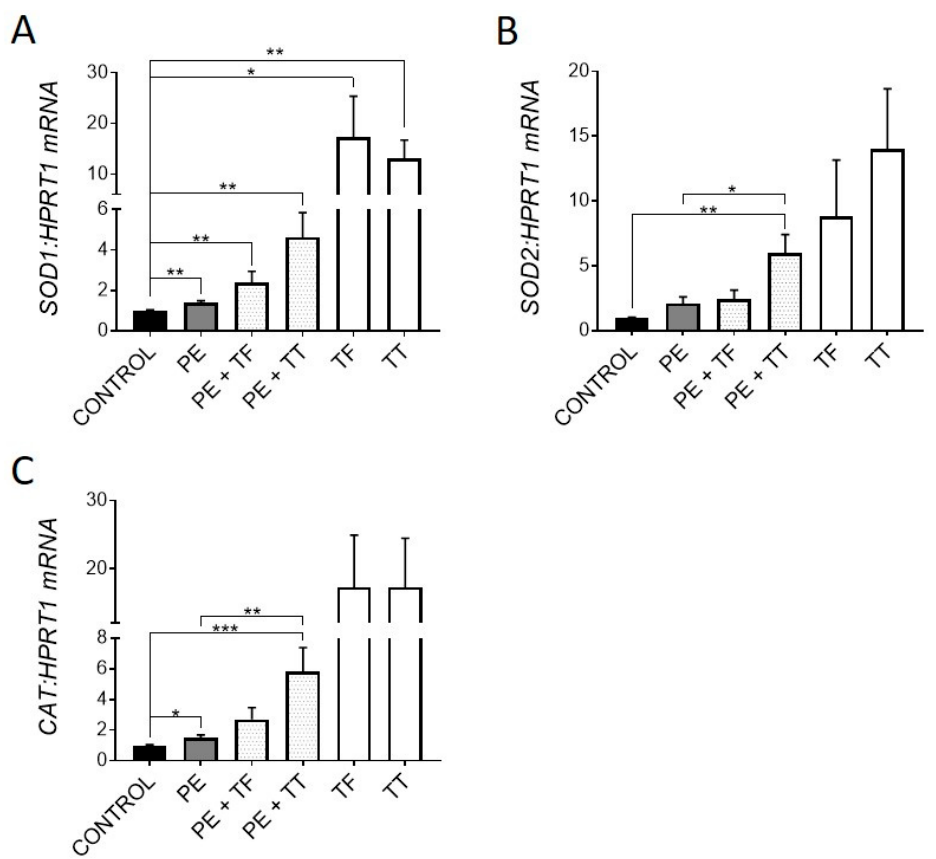
Figure 1. Effect of vitamin E and UHMWPE particles on antioxidant gene expression. Human osteocyte-like cultures were overlaid with collagen gel containing UHMWPE particles (PE) and either α -Tocopherol (TF) or γ -Tocotrienol (TT), and cultured for a further 21 d. Relative gene expression was measured for antioxidant genes SOD1 , SOD2 and Catalase ( A – C ). Data shown are means ± standard error of the mean (SEM) of quadruplicate experiments analysed in duplicate. Significant differences are denoted by * p < 0.05, ** p < 0.01, *** p < 0.001.